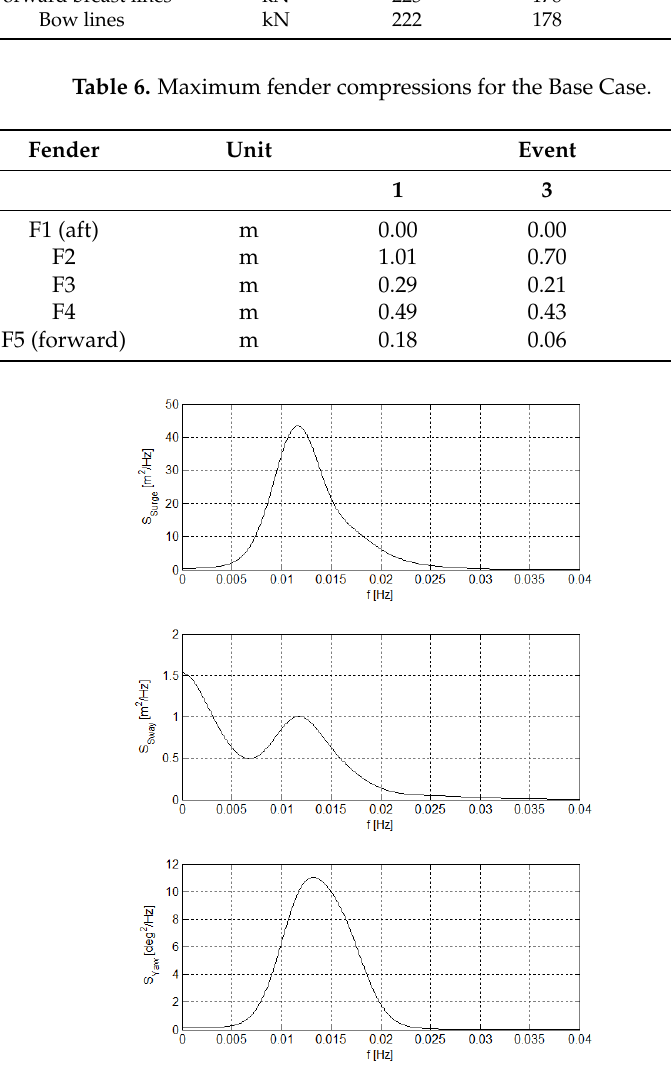
Figure 11. Sprectra of surge, sway. and yaw for the Base Case, Event 1.